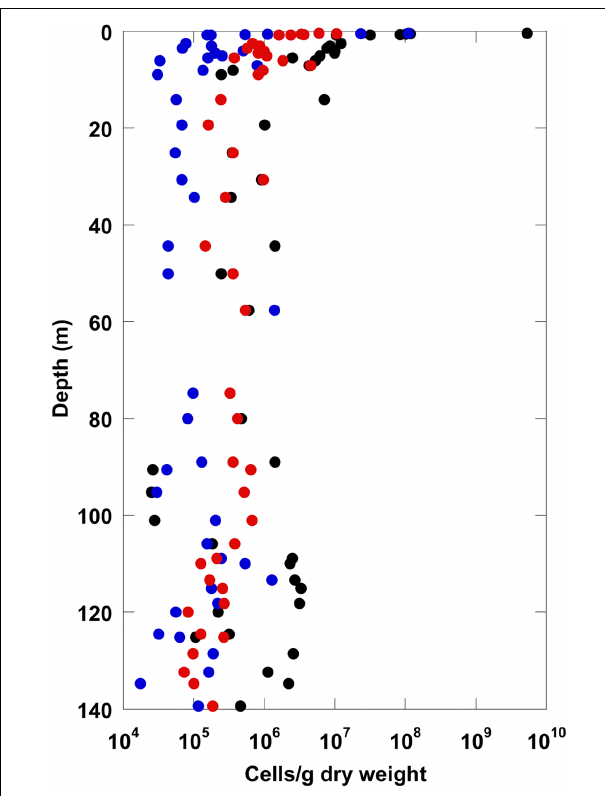
FIGURE 1 |Total cell counts for the terrestrial CBIS post-impact sediment obtained with three different methods (black: method Weinbauer et al., 1998; red: method Kallmeyer et al., 2008; blue: method Lunau et al., 2005).